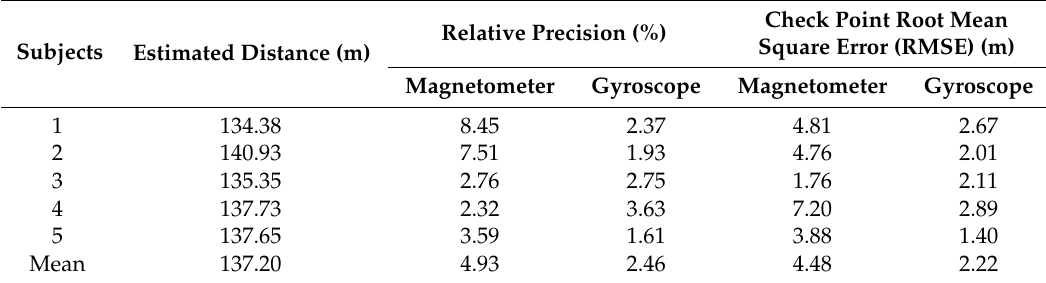
Figure 10. The experimental trajectories of PDR. Subfigure ( A ) shows the experimental route and check points; Subfigures ( B ), ( C ), ( D ), ( E ) and ( F ) are the results of five participants, respectively. The blue and red dotted line represent the solution with the usage of heading information from the magnetometer and gyroscope, respectively. The numbers indicate the different classrooms. Table 4. The result of relative precision for all subjects.